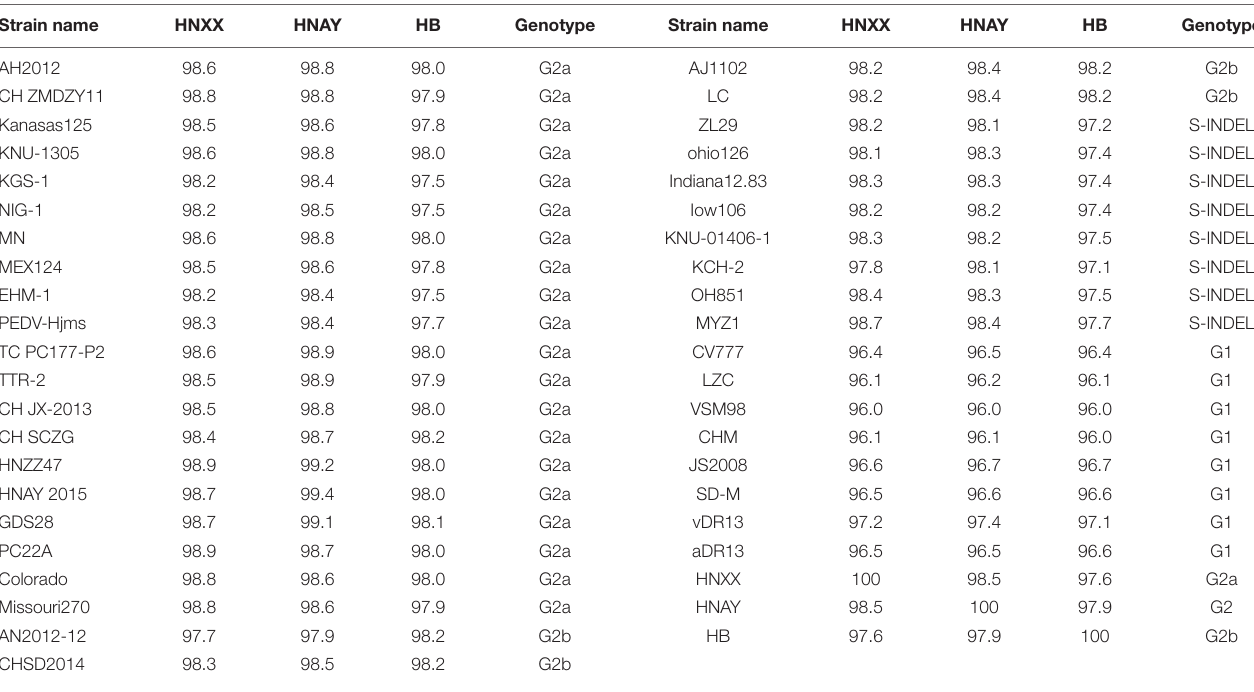
TABLE 2 | Nucleotide sequence identity (%) of complete genome of different PEDV